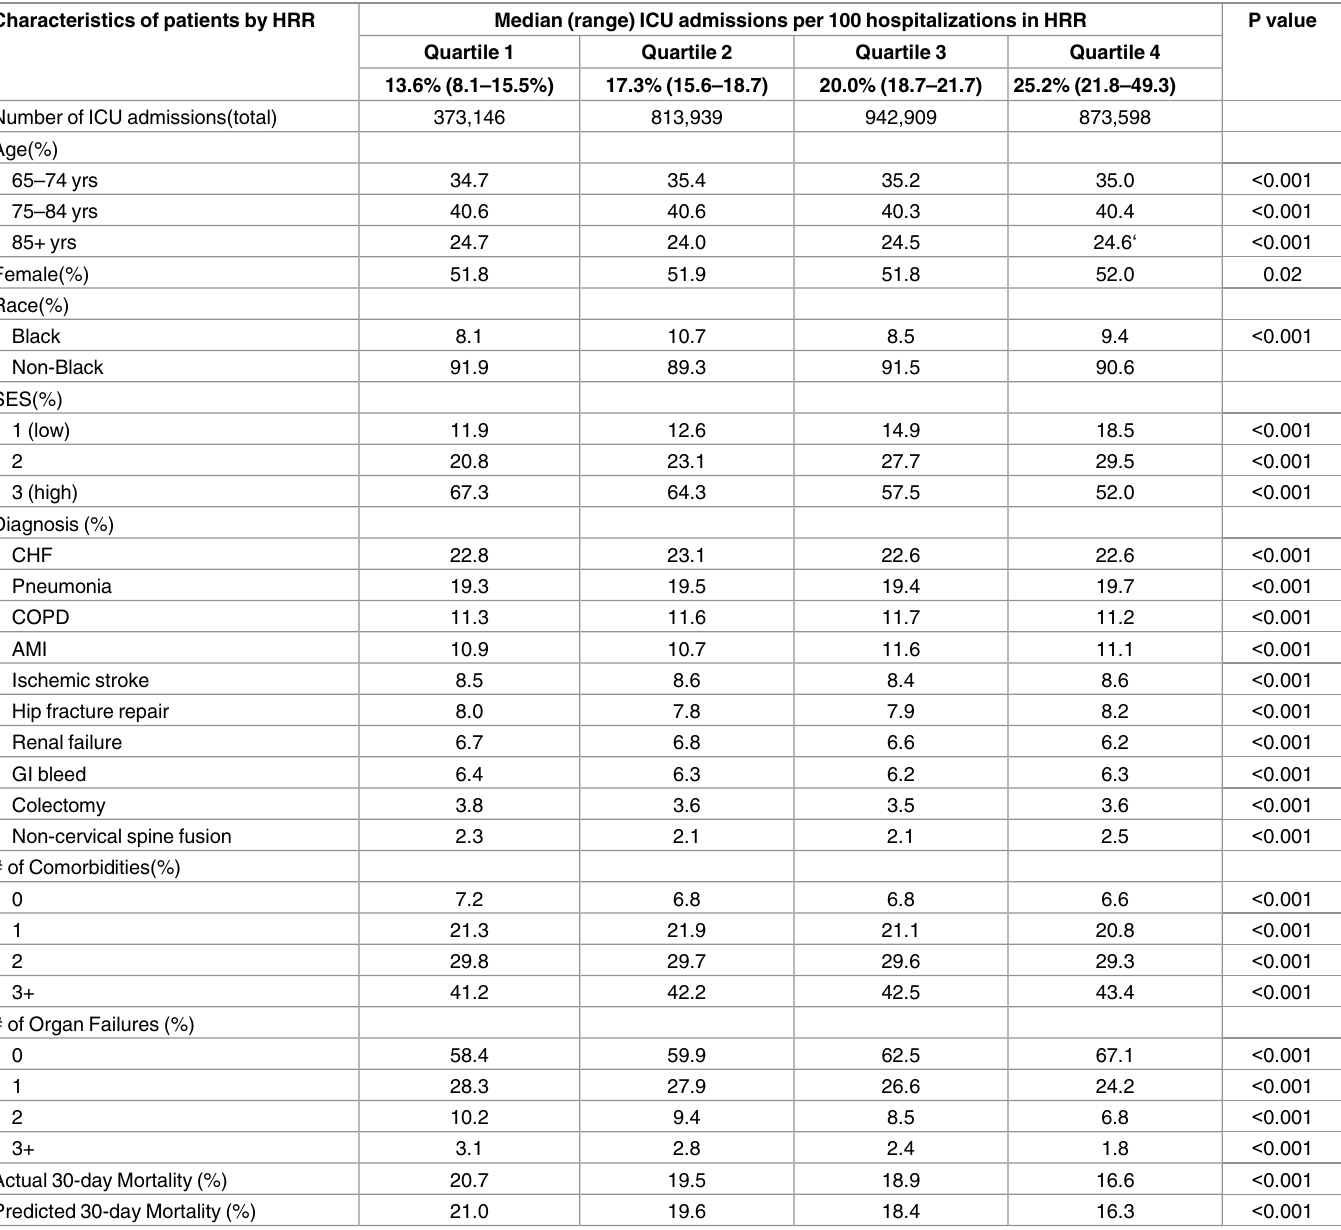
Table 1. Characteristics of patients across HRR quartiles of age, sex, race, standardized ICU utilization. Characteristics of patients by